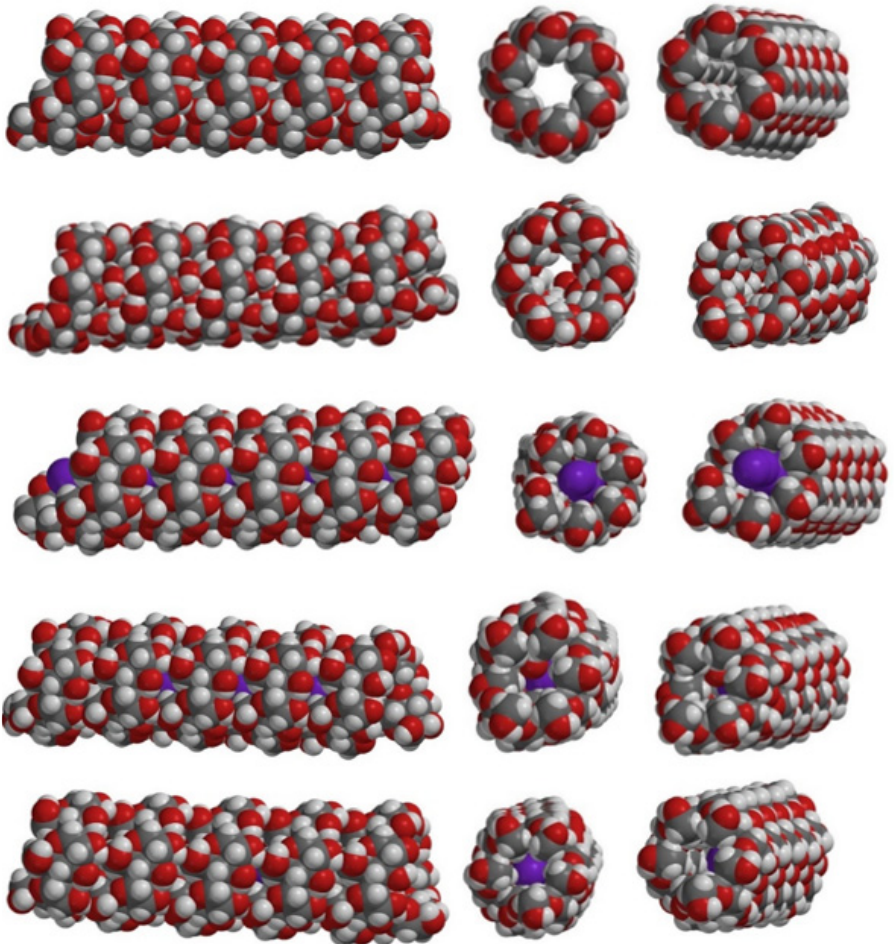
Figure 1. Structures of AM1-optimized amylose models, in order of rows: A, A-H 2 O, A-I 2 , A-I 2 -H 2 O, A-I 3- .